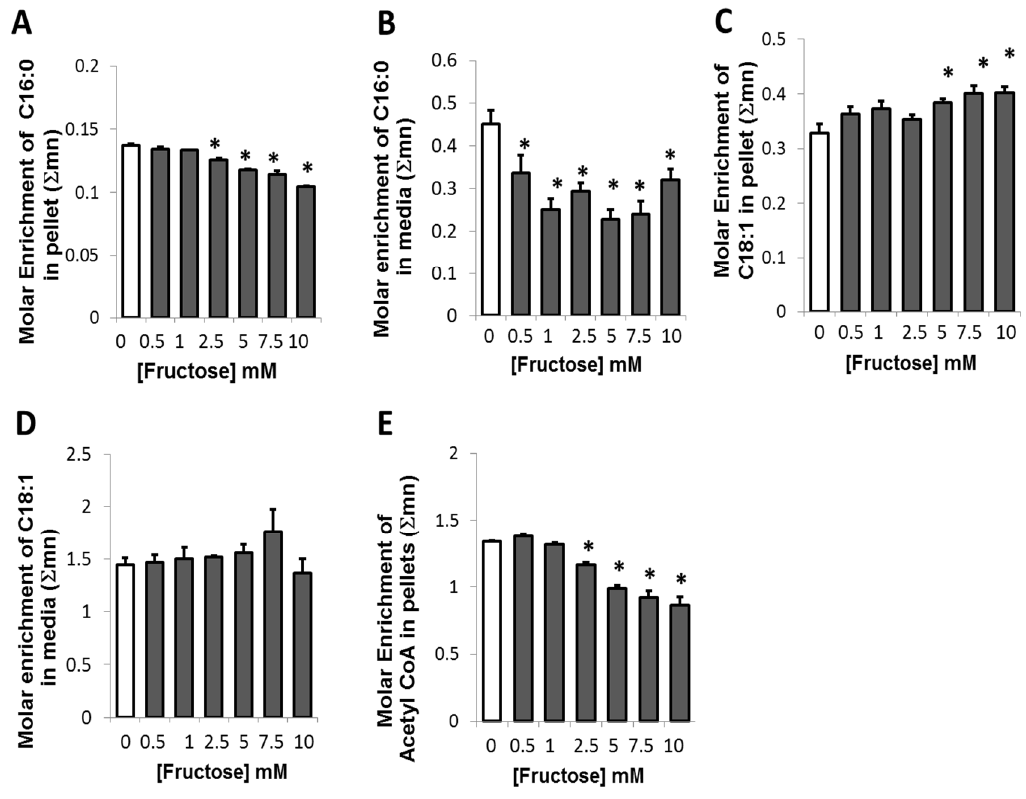
Figure 2. Glucose-derived 13 C fatty acid and 13 C acetyl-CoA in adipocytes in the presence of fructose in a medium containing a baseline amount of 5 mM of glucose ( A ) Glucose-derived intracellular 13 C Palmitate (C16:0) synthesized ( B ) Glucose-derived 13 C Palmitate (C16:0) released. ( C ) Glucose-derived intracellular 13 C Oleate (C18:1) synthesized ( D ) Glucose-derived 13 C Oleate (C18:1) released ( E ) 13 C glucose-derived acetyl-CoA formed in adipocytes and recovered from palmitate. In each case, ten percent of glucose was supplied as [1,2- 13 C 2 ]- D - glucose for a period of 48 h before harvest. * p < 0.05 compared to 0 mM of fructose. Oleate is a C18:1 unsaturated fatty acid that is formed by the elongation and desaturation of